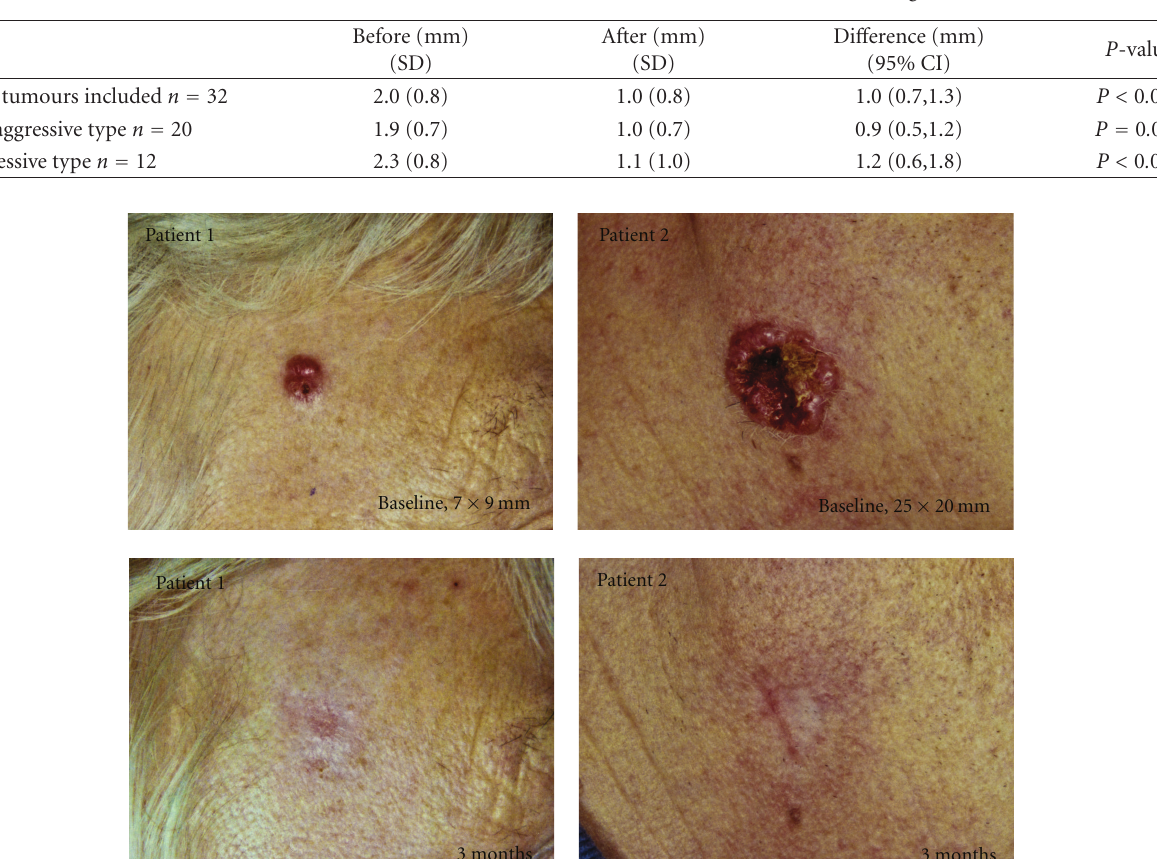
Figure 2: Response to deep curettage and MAL-PDT in thick BCC; patient 1 with a tumour on the temple and patient 2 with a tumour on the lower cheek. Cosmetic outcome was rated as good in both